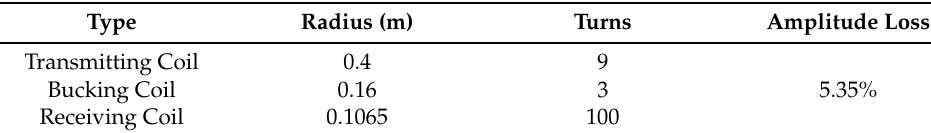
Table 1. Parameters of the coils.